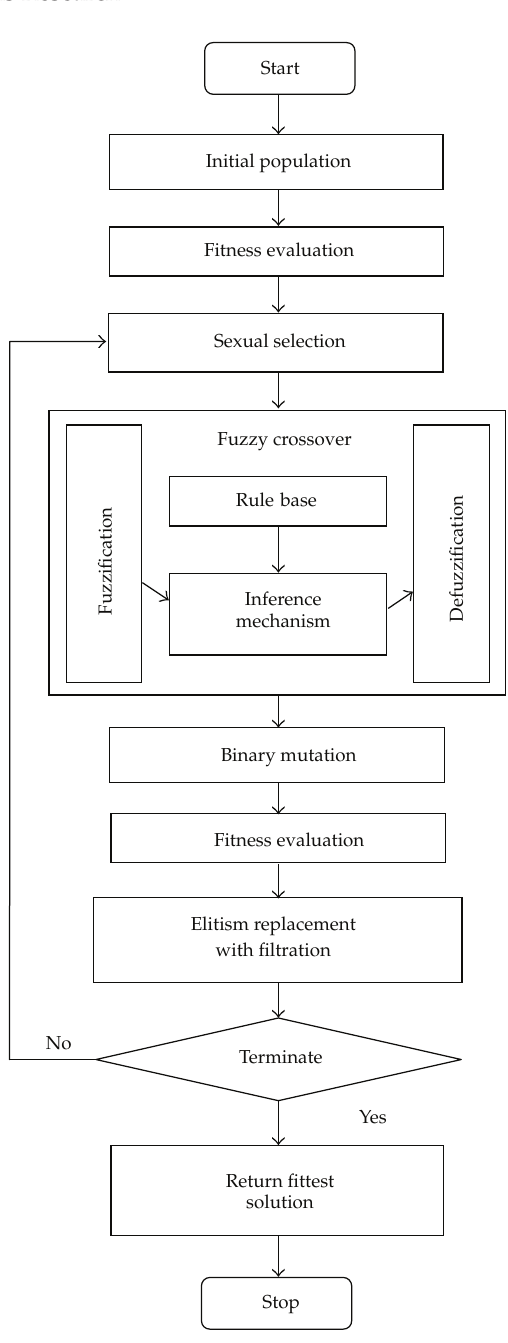
Figure 2: Framework of fuzzy genetic